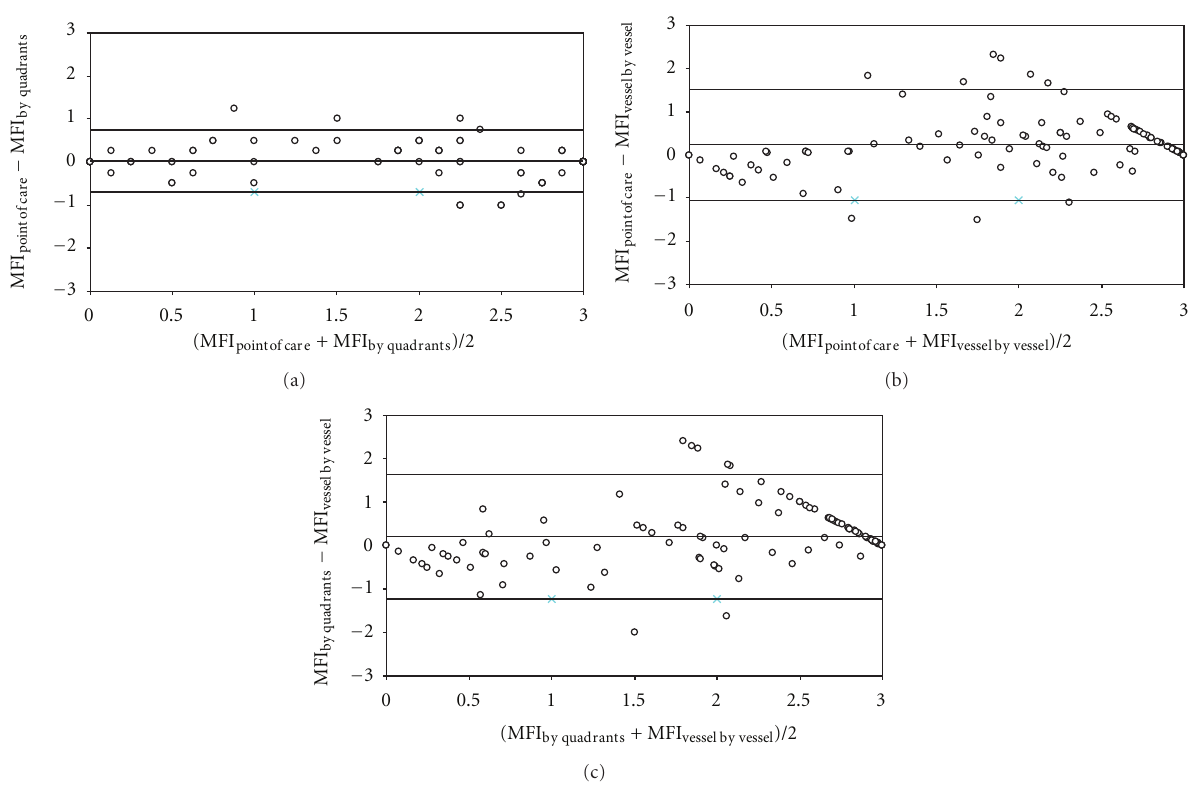
Figure 1: Bland and Altman analysis for the di ff erent methods used for the calculation of microvascular flow index (MFI). Panel (a): bedside point of care MFI (MFI pointofcare ) and MFI determined by quadrants (MFI byquadrants ). Panel (b): MFI pointofcare ) and MFI determined by vessel by vessel analysis (MFI vesselbyvessel ). Panel (c): (MFI byquadrants ) and (MFI vesselbyvessel ). Lines are bias and 95% limits of